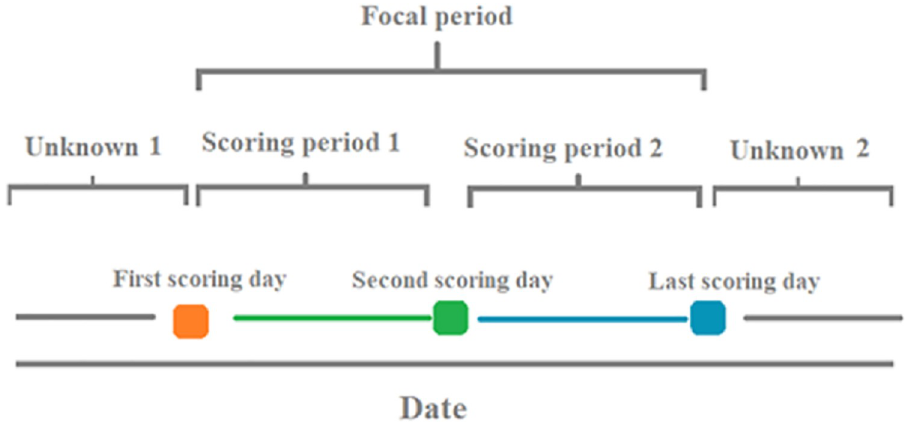
Fig 6. Timeline diagram of how focal periods were selected and how camera data was validated against injury / health scoring. Coloured squares indicate separate scoring events. The period of time between the first and last scoring event was identified as the focal period, and the space of time between consecutive scoring events were referred to as the scoring periods. The end of the batch (Unknown 2) was removed as no further injury scoring was gathered in order to validate the tail posture changes during this time. The start of the batch (Unknown 1) was removed due to variable data quality at the start of some batches.